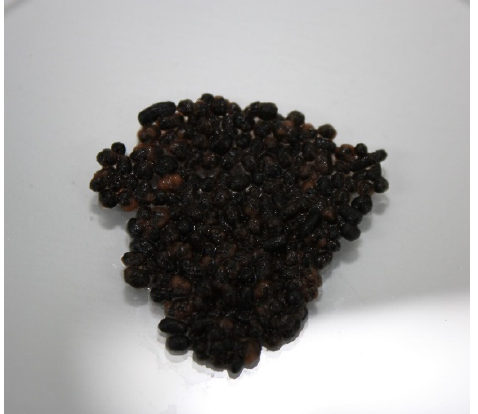
Figure 2. An AOB-loaded activated carbon